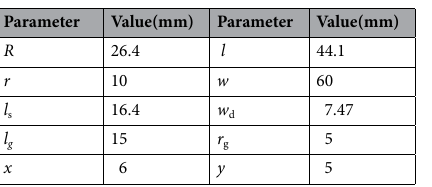
Figure 1. ( a ) The schematic diagram of the proposed UWB monopole microstrip antenna where there named as ( a ) Stru.A, ( b ) Stru.B, ( c ) Stru.C and ( d ) Stru.D.